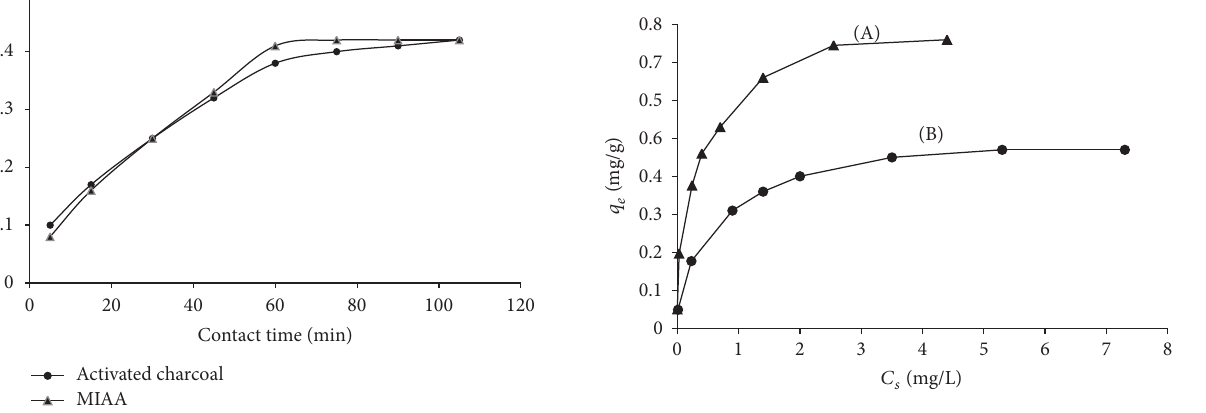
F 3: Effect of contact time on adsorption capacity of MIAA and activated charcoal at (20